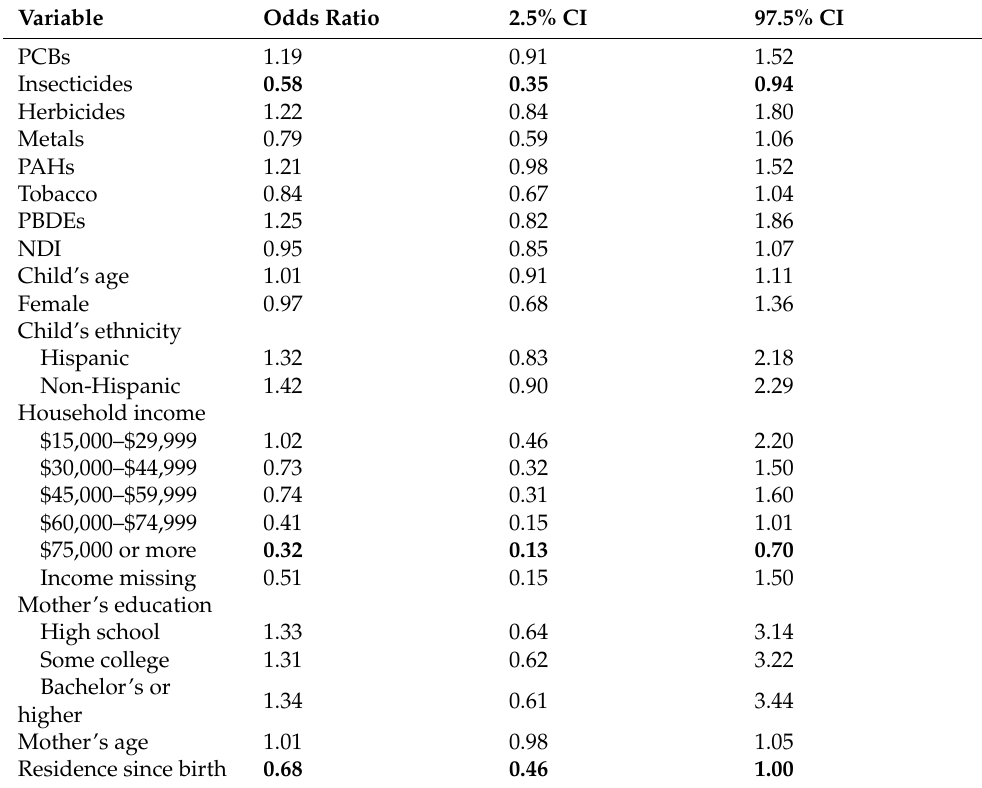
Figure 2. Posterior mean weights for variables in the covariate-adjusted model of neighborhood deprivation index for childhood leukemia. Note: components are Black segregation, Hispanic segregation, ratio of income to poverty <1, percent receiving public assistance income, percent of renters, percent with no high school diploma, percent in a different house than 1 year ago, percent foreign born, per capita income, median house value, and median gross rent. Table 2. Odds ratios and 95% credible intervals for the covariate-adjusted neighborhood deprivation index (NDI) and chemical exposure groups model for childhood leukemia.